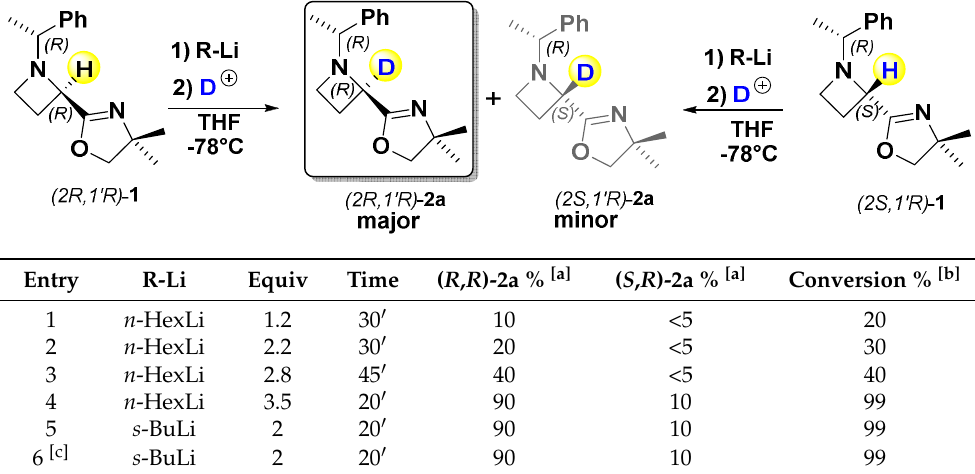
Table 1. Optimization of lithiation/deuteration sequence on diastereomeric oxazolinylazetidines (2 R ,1′ R ) -1 and (2 S ,1′ R ) -1 .